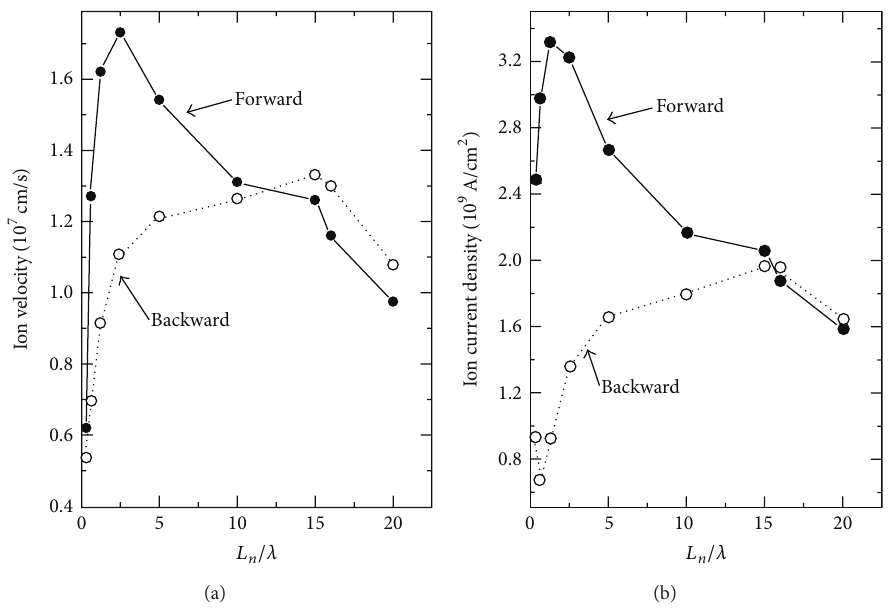
Figure 5: The dependencies of the maximum ion velocities (a) and the maximum ion current densities (b) on the plasma density gradient scale length. 𝜏 𝐿 = 1 PS, 𝐼 𝐿 = 10 16 W/cm 2 .